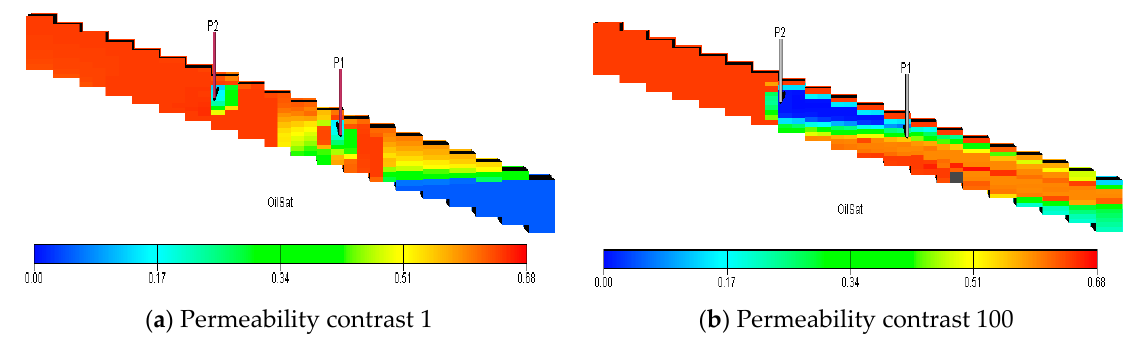
Figure 15. Oil saturation profiles after well stuffy.